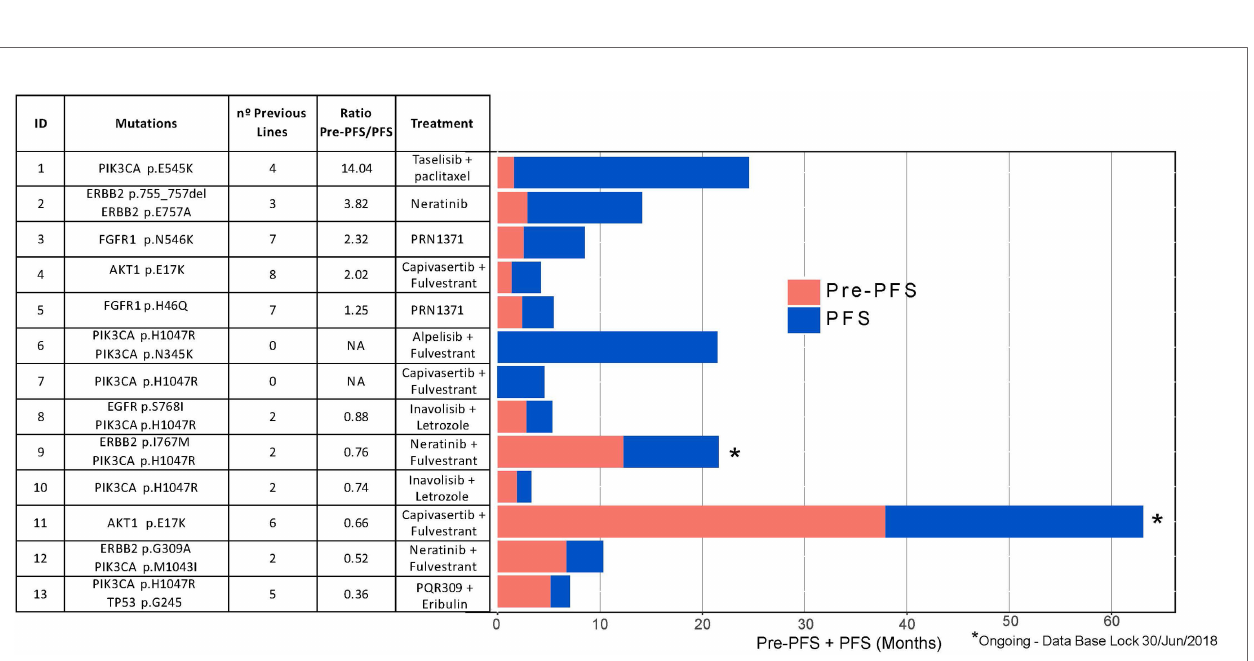
FIGURE 3 | Individual progression-free survival 1 (PFS1) and progression-free survival 2 (PFS2) among patients treated with genome-driven cancer therapy (n =